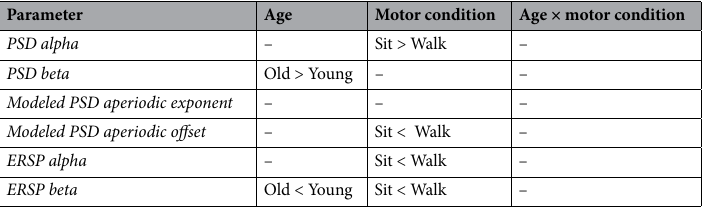
Table 1. Overview of ANOVA main and interaction effects of the PSD and TF